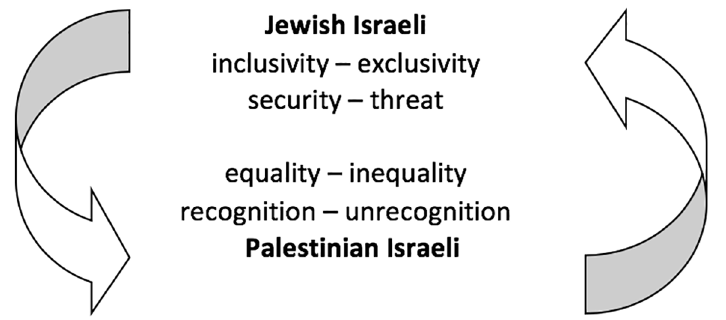
Figure 1. Themata observed across the contexts of work and